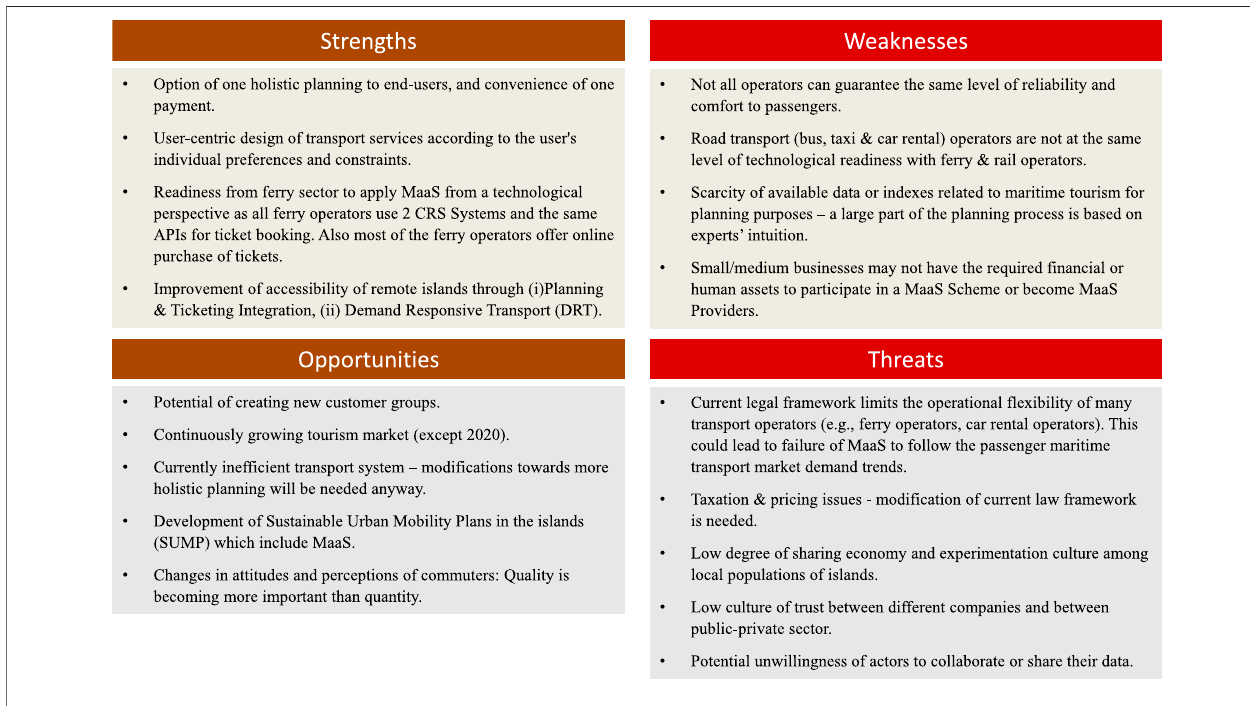
FIGURE 5 | A SWOT analysis for Maritime